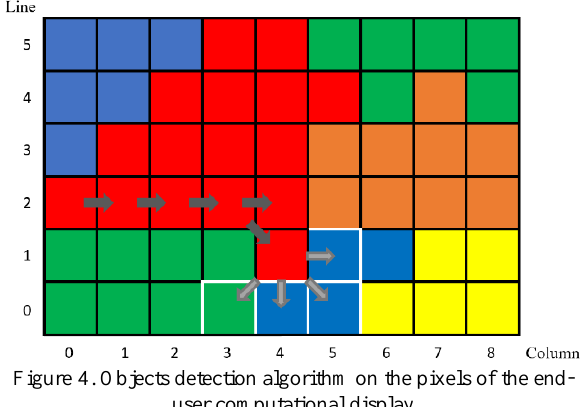
Figure 4. Objects detection algorithm on the pixels of the end- user computational